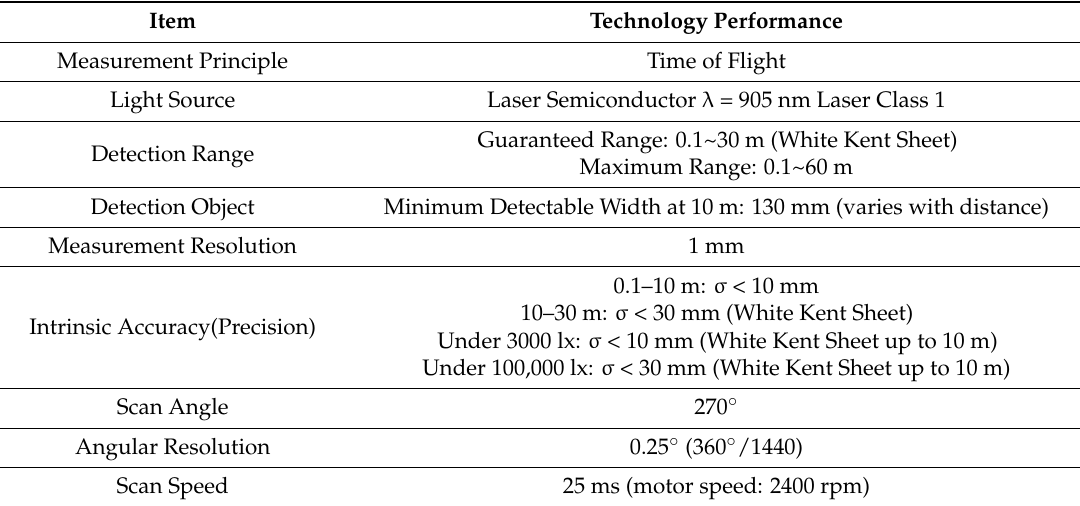
Table 1. Hokuyo UTM-30LX performance parameter table. The intrinsic accuracy is 10 mm with a scanning range from 0.1 m to 10 m.